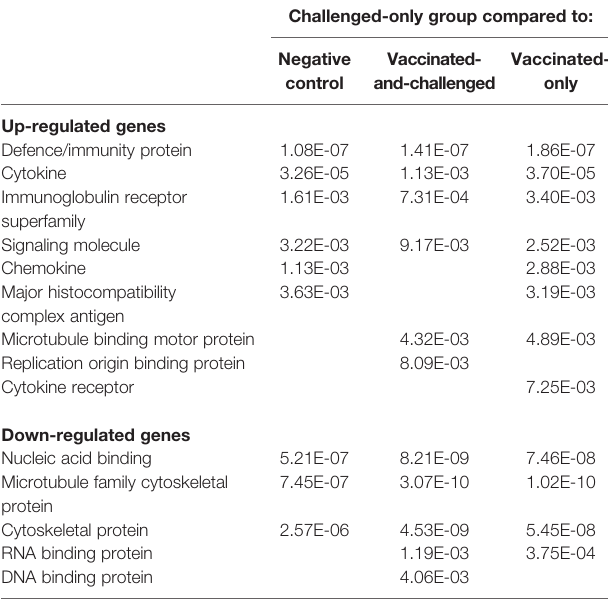
TABLE 5 | False discovery rates (FDR) of protein classes enriched with up- and down-regulated genes in the challenged-only group compared to the other groups. Challenged-only group compared to: Negative